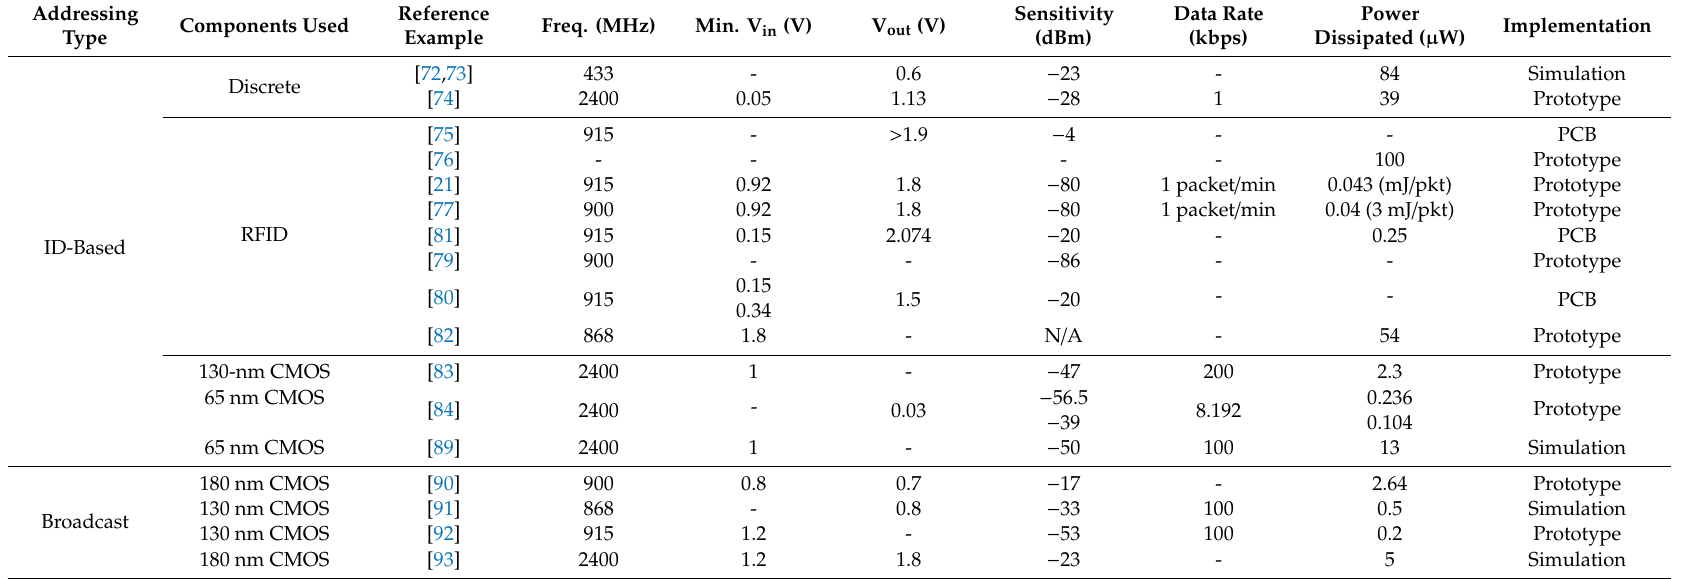
Table 1. Passive wake-up radio technology and its performance characteristics and